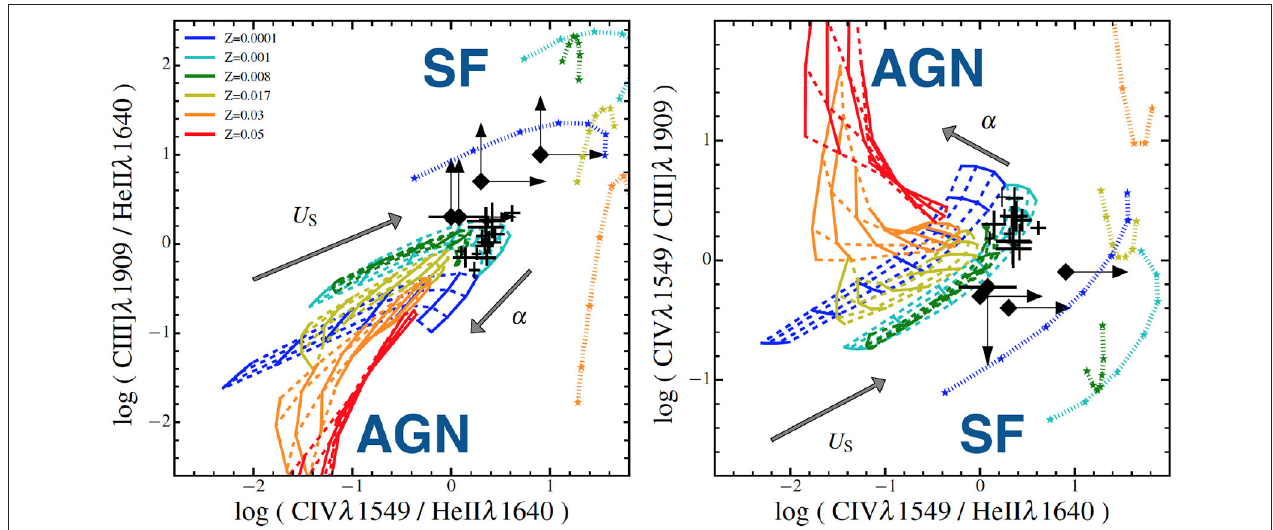
FIGURE 1 | Predictions of the AGN NLR and star-forming galaxy models described in section 2 in the diagnostic diagrams C IV λ 1550/He II λ 1640 vs. C III ] λ 1909/He II λ 1640 and C IV λ 1550/C III ] λ 1909 ( left and right , respectively). Dashed and continuous lines are AGN models corresponding to wide ranges in power-law index, α , and ionization parameter, − 4.0 < log( U ) < − 1.0. Stars connected by dotted lines are star-forming galaxy models. All the models are shown for different metallicity Z (color coded as indicated on the left panel). Also shown in each panel are the observations of AGN (crosses with error bars) and star-forming galaxies (large diamonds with upper and lower limits) described in section